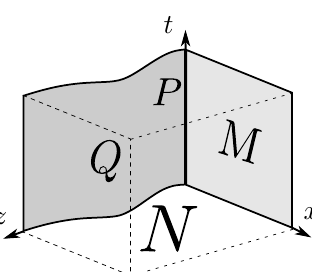
Figure 1 . Setup for the holographic description of a BCFT according to [10]. The asymptotically AdS bulk spacetime N has the conformal boundary M and additional boundary Q . The defect P is the intersection of M and Q . We have used standard coordinates t; x; z as in (2.3), where t; x